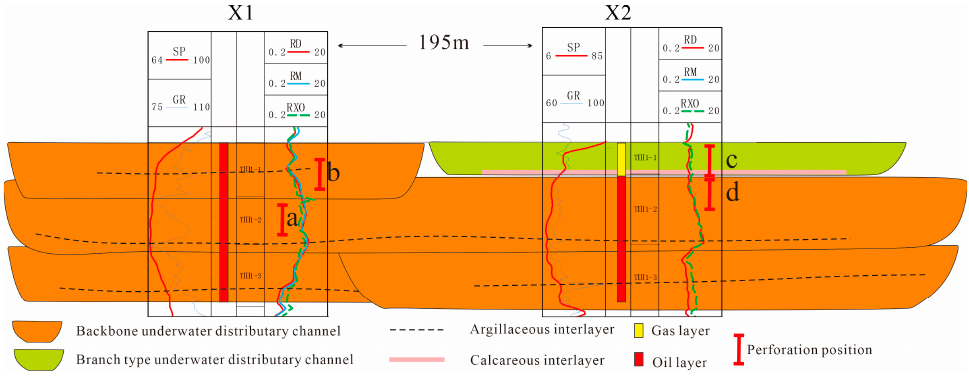
Figure 11. Architecture profile of wells X1 and X2 in the Sangtamu oilfield: a, b, c and d refer to the perforation position.